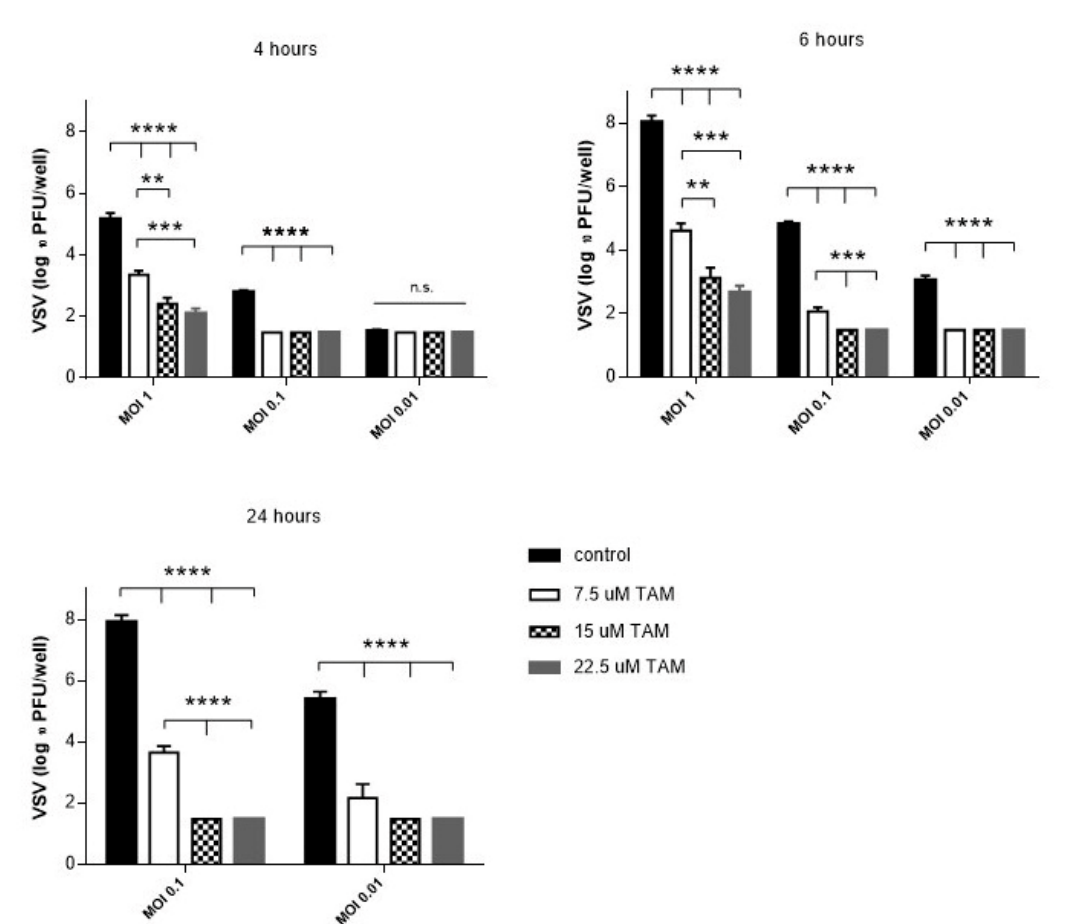
Figure 1. Tamosifen (TAM) pretreatment resulted in the inhibition of replication of vesicular stomatitis virus (VSV) in vitro. Vero cells were treated with 7.5 μ M, 15 μ M, 22.5 μ M TAM, or 1 μ L dimethyl sulfoxide (DMSO) used as a control for 24 hours, and then infected with 0.01, 0.1, and 1 MOI of VSV for 1 h; the cells were washed with phosphate buffered saline (PBS) and fresh medium was added. VSV titers in cell supernatant were measured at 4 h, 6 h and 24 h after infection by plaque assay ( n = 5). Data are expressed as means ± SEM. n.s.: not significant, ** p = 0.01; *** p = 0.001; **** p < 0.001.